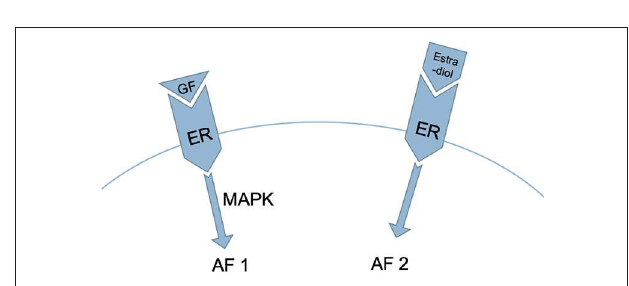
FIGURE 3 | Two regions in the ER are involved in the process described in Figure 2 : activation function 1 (AF1), which is activated by growth factors acting via the mitogen-activated protein kinase [MAPK] pathway, and activation function 2 (AF2), which is activated by estrogen (20, 21).